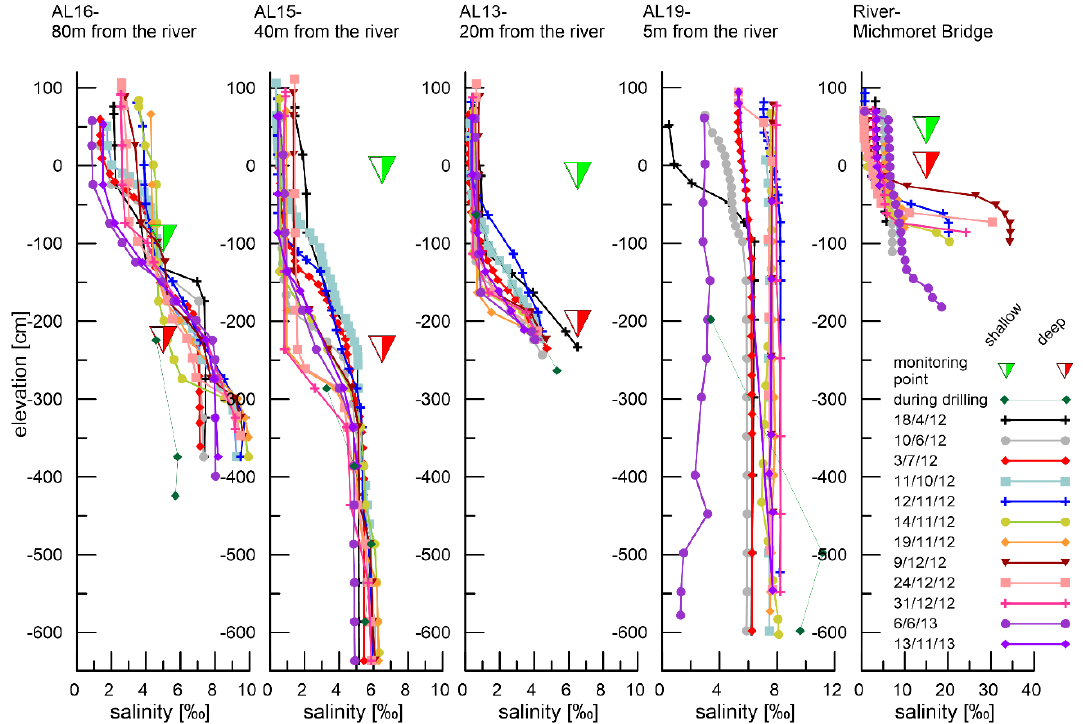
Figure 6. Salinity profiles in the Dune site, compared with river profiles at the Michmoret Bridge, 500 m from the sea. Note the differences in salinity scale. Also shown are the monitoring depths of the monitoring points (data shown in Figure 8).